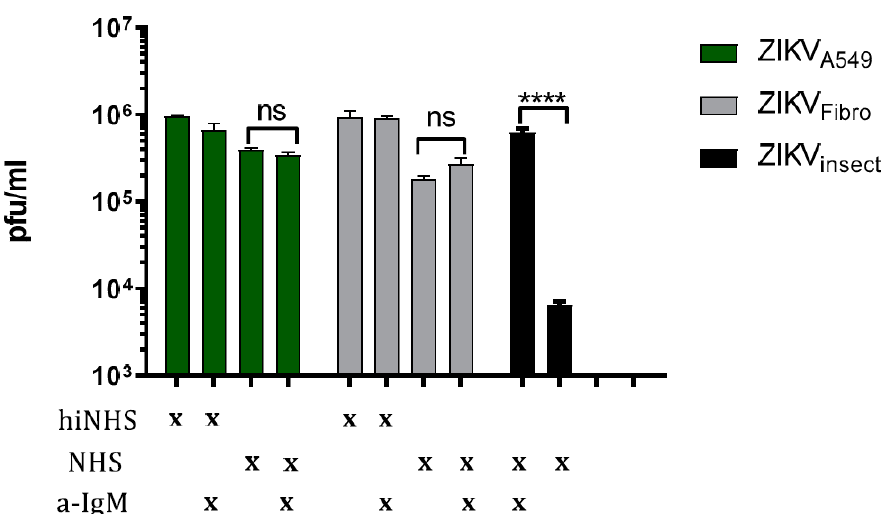
Figure 2. Effect of IgM on complement activation. To investigate whether natural serum IgMs affect the complement activation of human cell-derived ZIKV, anti-human IgM blocking antibodies were incubated in 50% NHS or hiNHS for 30 min on ice, before ZIKV A549 or ZIKV Fibro were added. The experimental conditions are indicated by “x”. As positive control, ZIKV insect was included [13]. After incubation for 1 h at 37 ◦ C, the virus–serum mixture was serial diluted and titrated on 12-well plates of overnight-plated Vero cells. One hour after incubation at 37 ◦ C, plaque agarose was overlaid. Viral concentration was determined and calculated four days post-infection using crystal violet staining. All virus lysis experiments were conducted in triplicate, and the error bars show standard